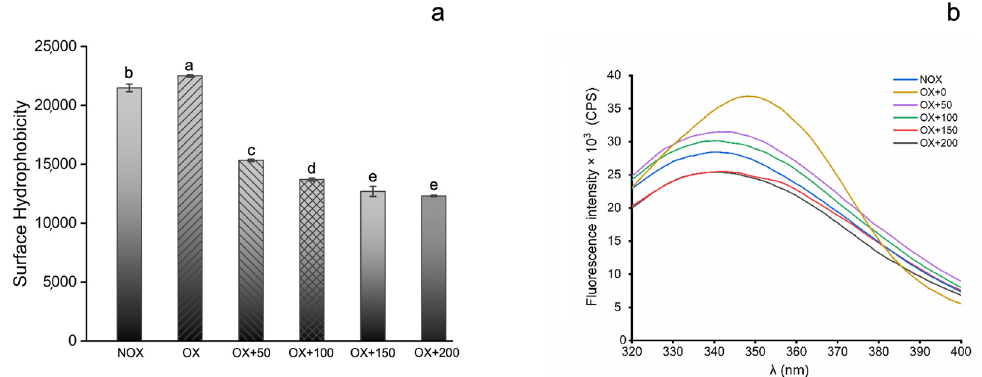
Figure 1. Surface hydrophobicity ( a ) and intrinsic tryptophan fluorescence ( b ) on MPs treated with various concentrations of FOs (0, 50, 100, 150, and 200 µ mol/g protein) under nonoxidizing (NOX) or oxidizing (OX) conditions. Different lowercase letters represent significant differences between samples ( p < 0.05).